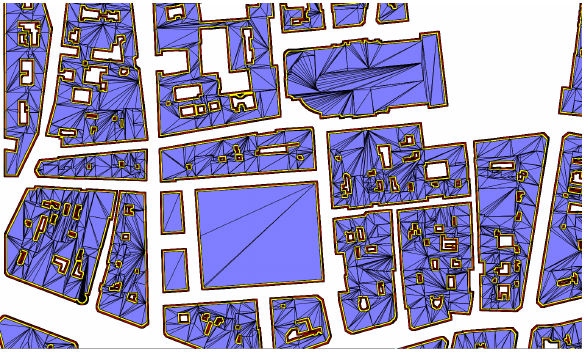
Figure 8: GIS view of the uncertain 3D scene obtained by the minkowski sum (red) and difference (blue) of the original 2.5D building database (yellow). The near and far ground surfaces (MNT) are not shown here for clarity.